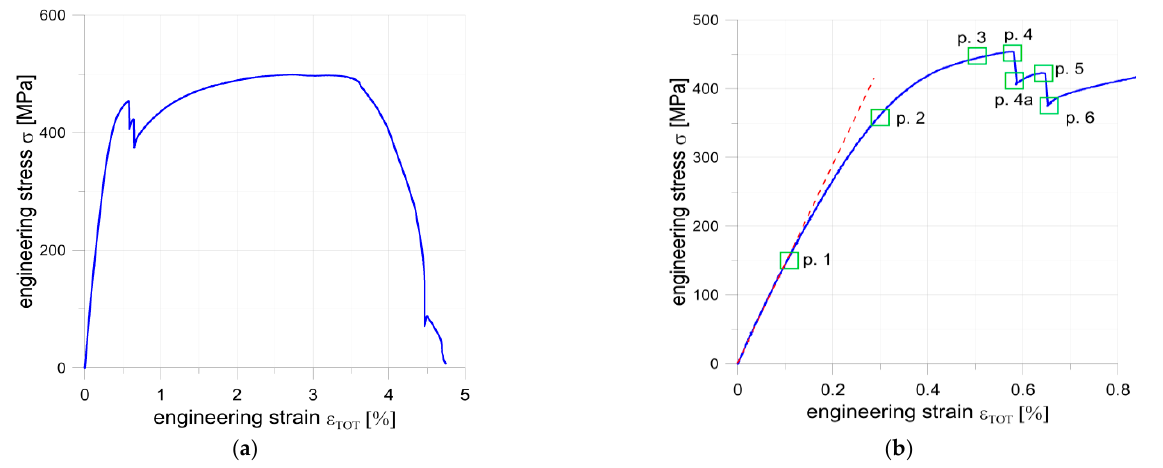
Figure 14. Engineering stress–strain curve for sample no. 5 with a rectangular cut-out with a fillet radius R2 and composite overlays: ( a ) behavior in full range of strain; ( b ) enlargement of initial range of strain.